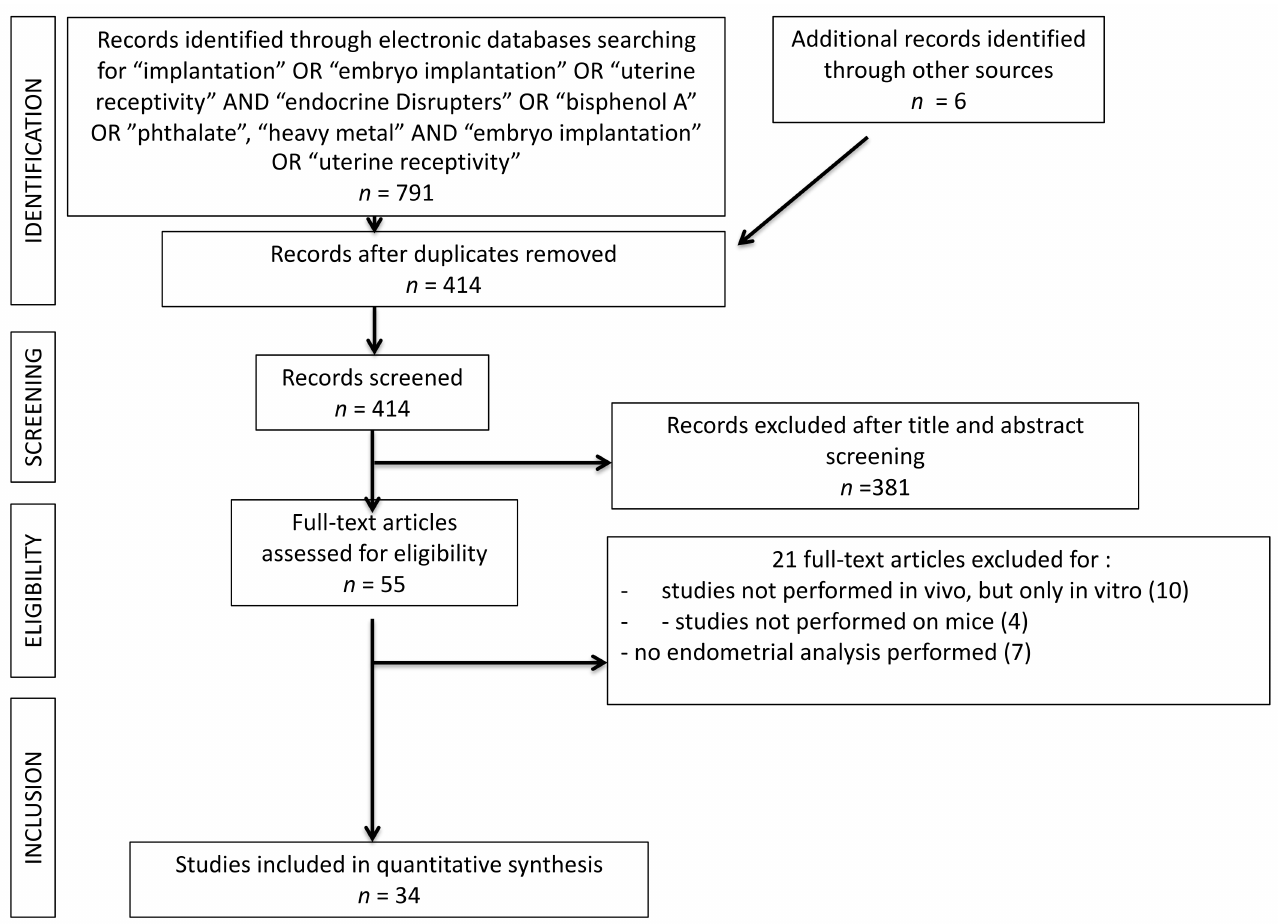
Figure 2. PRISMA flow chart. 381 records were excluded after title and abstract screening because, basing on inclusion and exclusion criteria, they were not pertinent with the searched